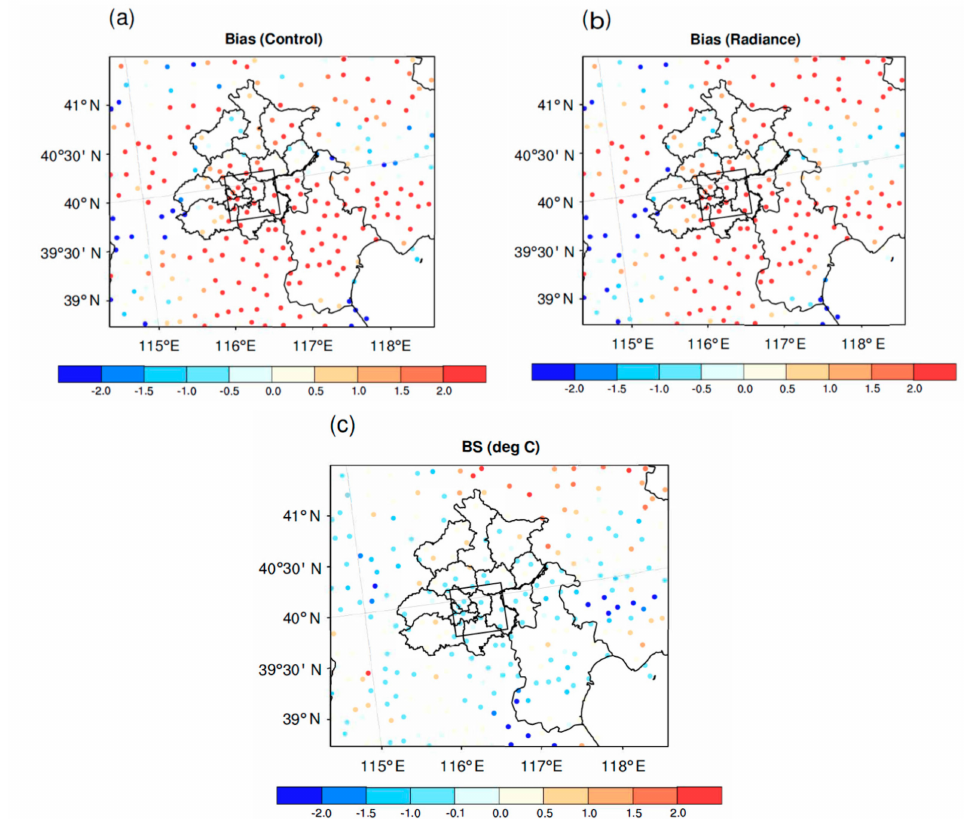
Figure 8. ( a , b ) The bias of 2 m temperature (unit: ◦ C) from control experiment and the bias of 2 m temperature from MWRPS experiment; ( c ) improving index (unit: ◦ C) with the assimilation of ground-based microwave radiometers at 0700 UTC on 21 May 2020.